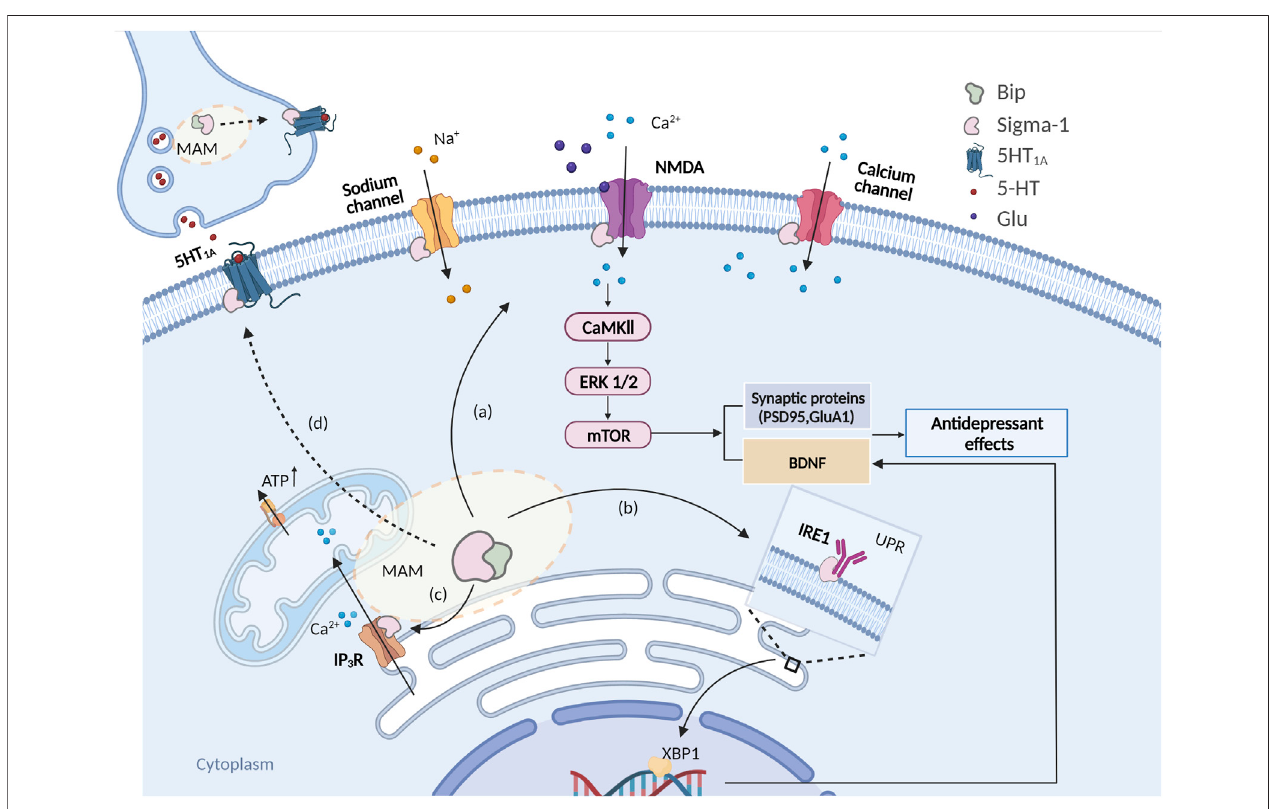
FIGURE 1 | Schema of intracellular signaling pathways involved in the antidepressant-like effects of sigma-1 receptors. (A) Sigma-1 receptors are activated and translocatedtotheplasma membrane tointeractwiththeNMDAR ofpyramidalcells, which wouldresult inarapidintracellularactivation ofCaMKIIthatwould eventually activate (phosphorylate) intermediates in the ERK1/2 and mTOR pathways, thus inducing a rapid synthesis of PSD95, BDNF etc; (B) Sigma-1 receptors are activated and then disassociate from Bip thus stabilizing IP3R, maintaining the Ca 2+ fl ow from the ER to mitochondria and ATP production; (C) Sigma-1 receptor activates and thus binds and modulates the ER stress response via ER stress sensors IRE1 and facilitates BDNF expression via the IRE1-XBP1 signaling pathway. (D) Sigma-1 receptors may also modulate 5HT1A function through sigma-1 receptor-5HT1A